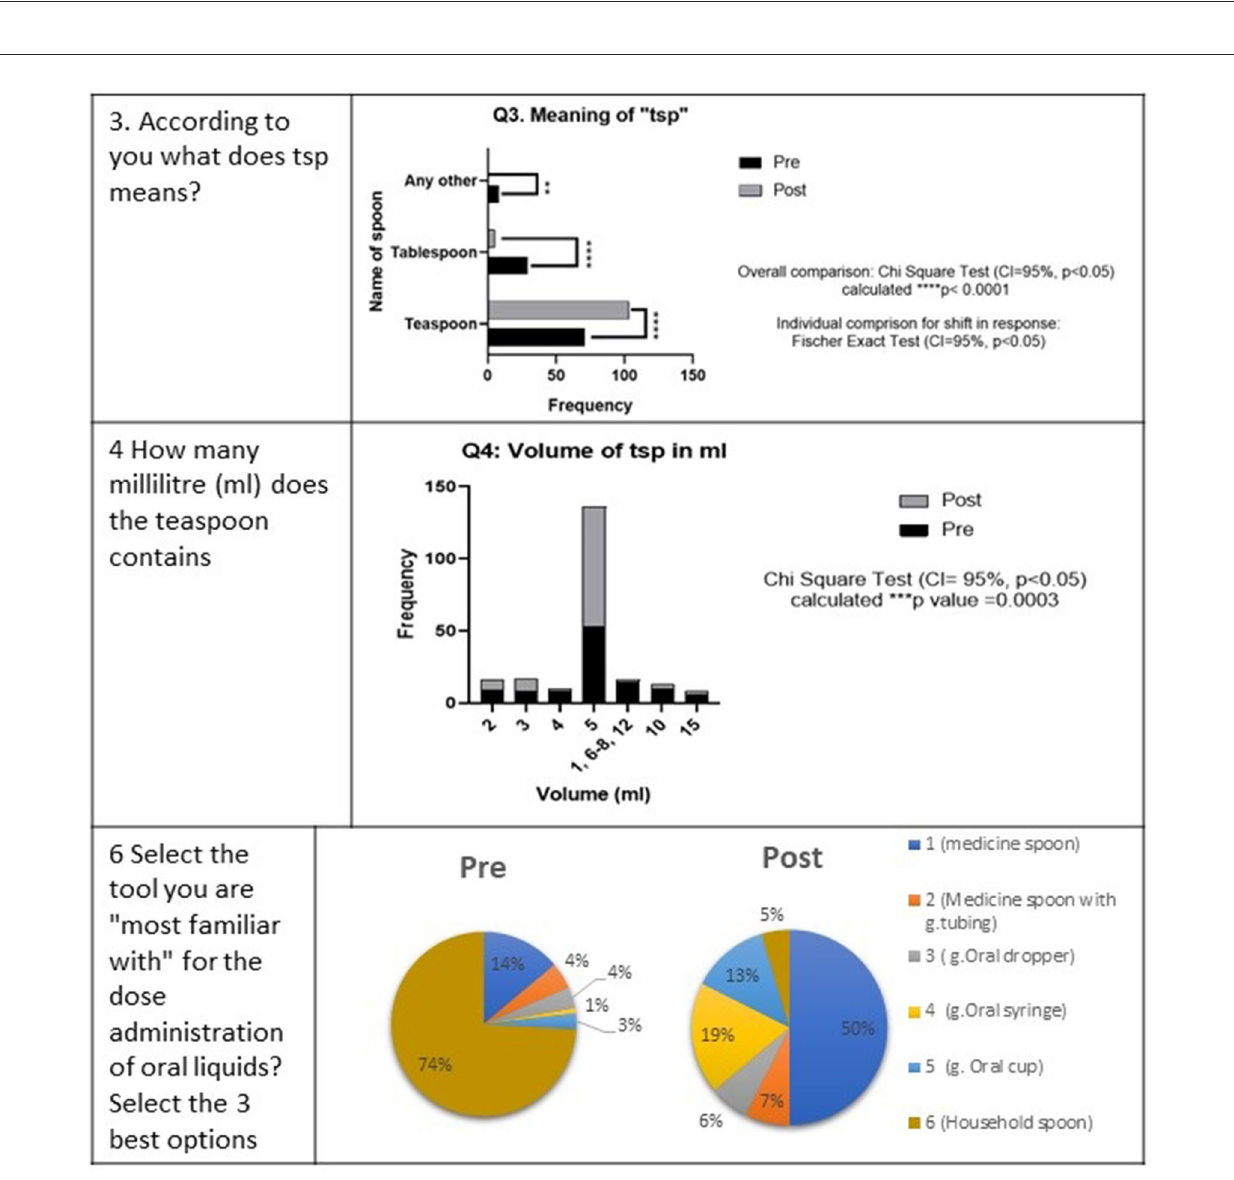
FIGURE5 Comparison of pre- and post-intervention responses of the survey participants on the choice of a spoon for medicine administration. ** means very significant. *** means highly